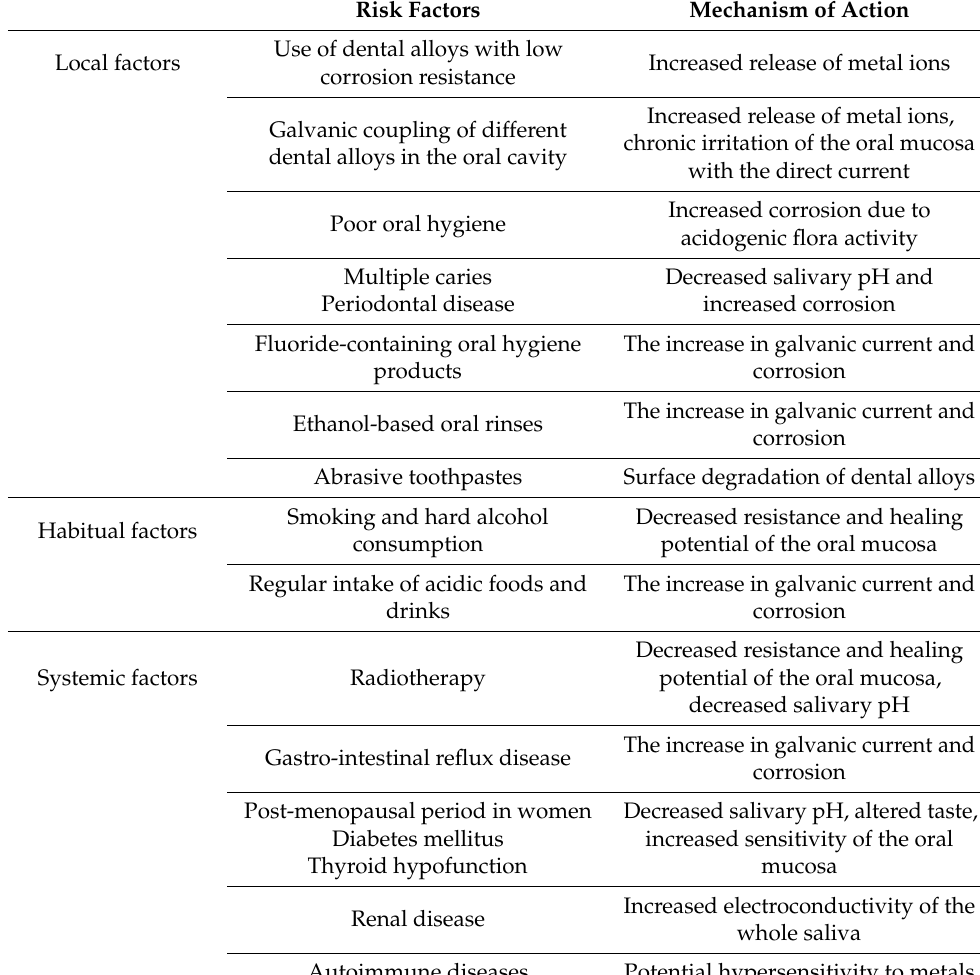
Table 1. Factors increasing the risk of adverse effects associated with dental